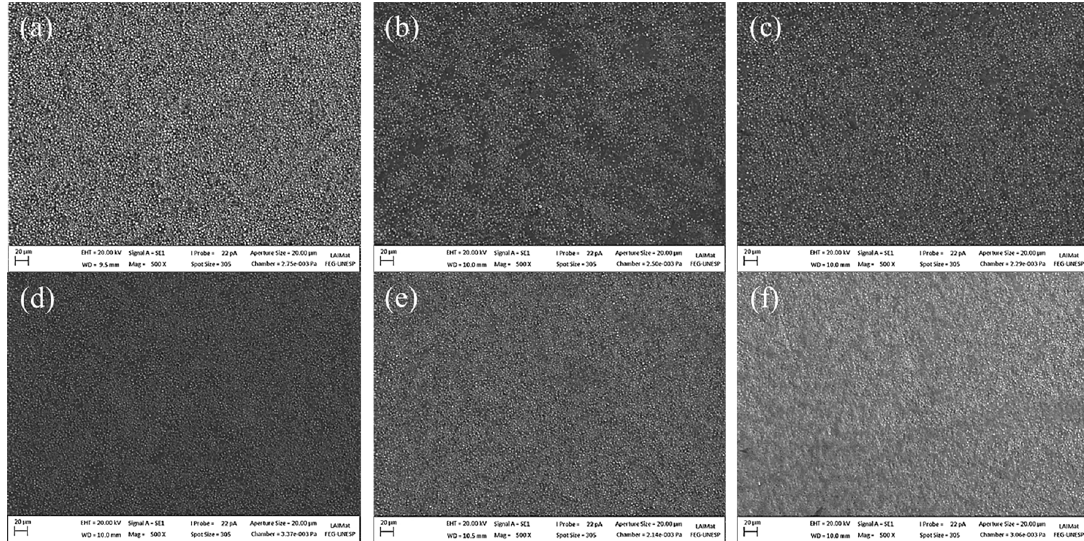
PO solution, in mol L -1 ): 0.25 (a-c), 2.5 (d-f). 3 4